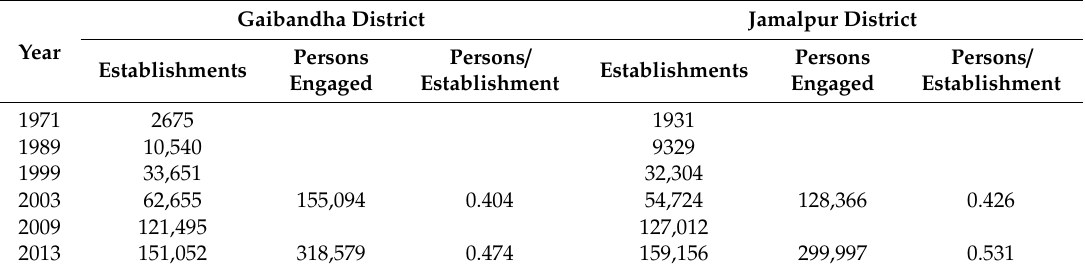
Table 1. Non-farm economic activities: number of establishments and employees [37,38].